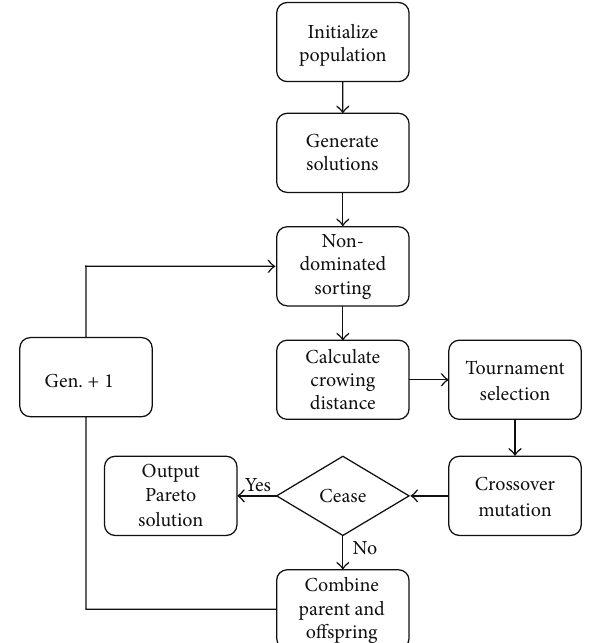
Figure 2: Flow chart of